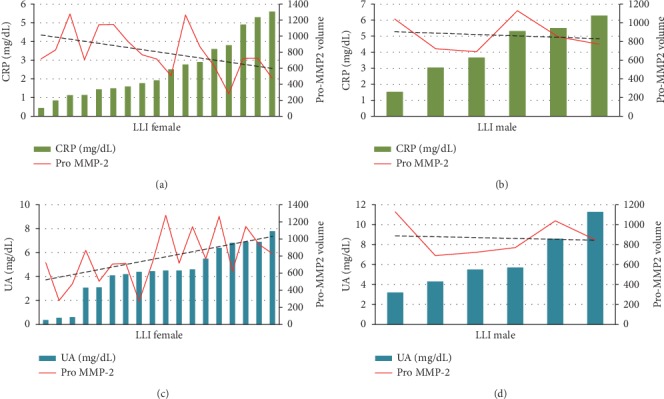
Histograms of Pro-MMP-2 activity levels in the LLI group and hematological values of CRP (a, b) and UA (c, d) in female (a–c) and in male (b–d) to show the found correlations. The trend of the line in hematological parameters shows a positive or inverse correlation.